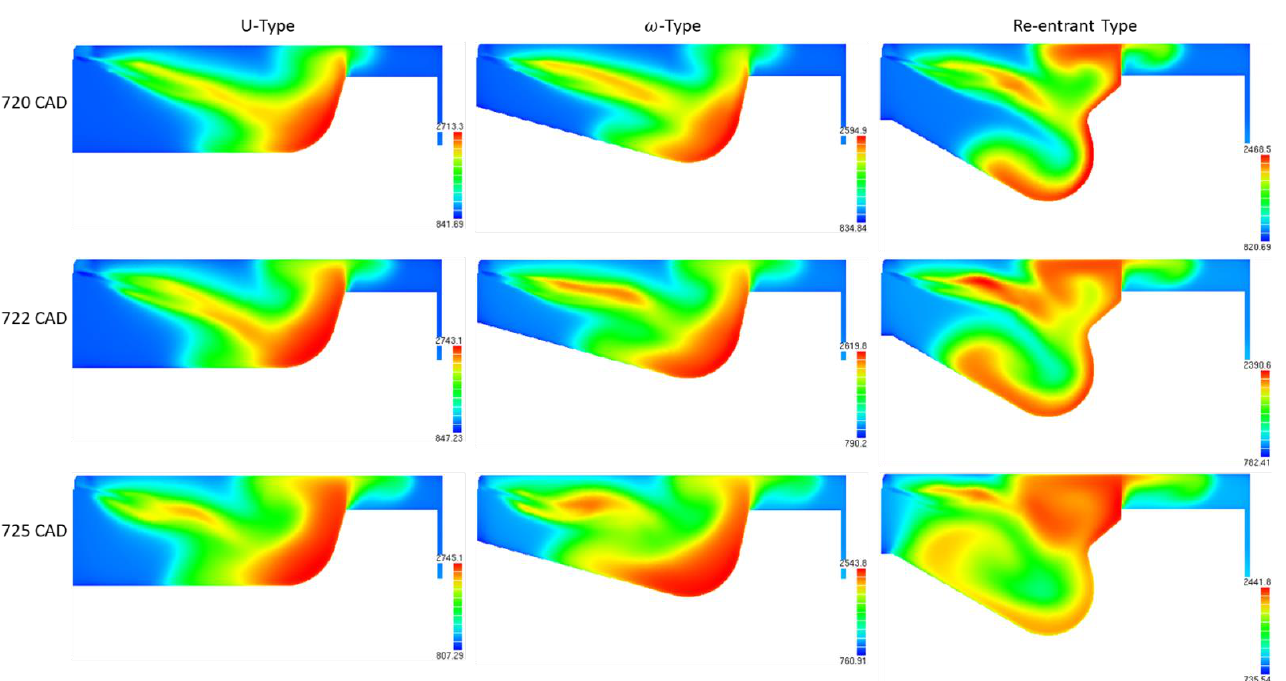
Figure 7. Temperature distribution inside the engine cylinder at some CADs.